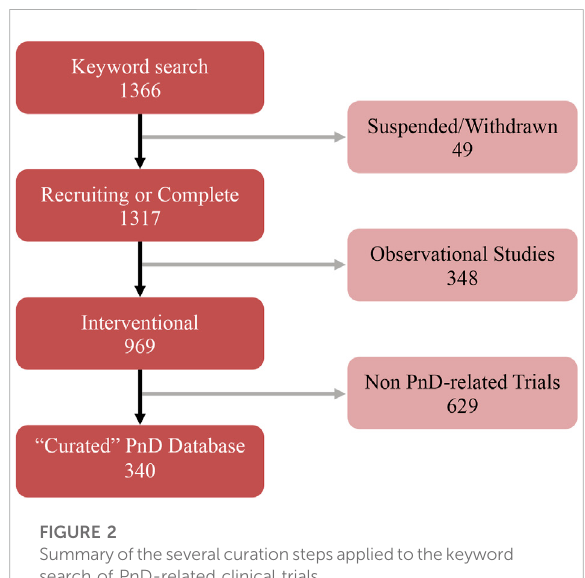
FIGURE 2 Summaryoftheseveralcurationstepsappliedtothekeyword search of PnD-related clinical